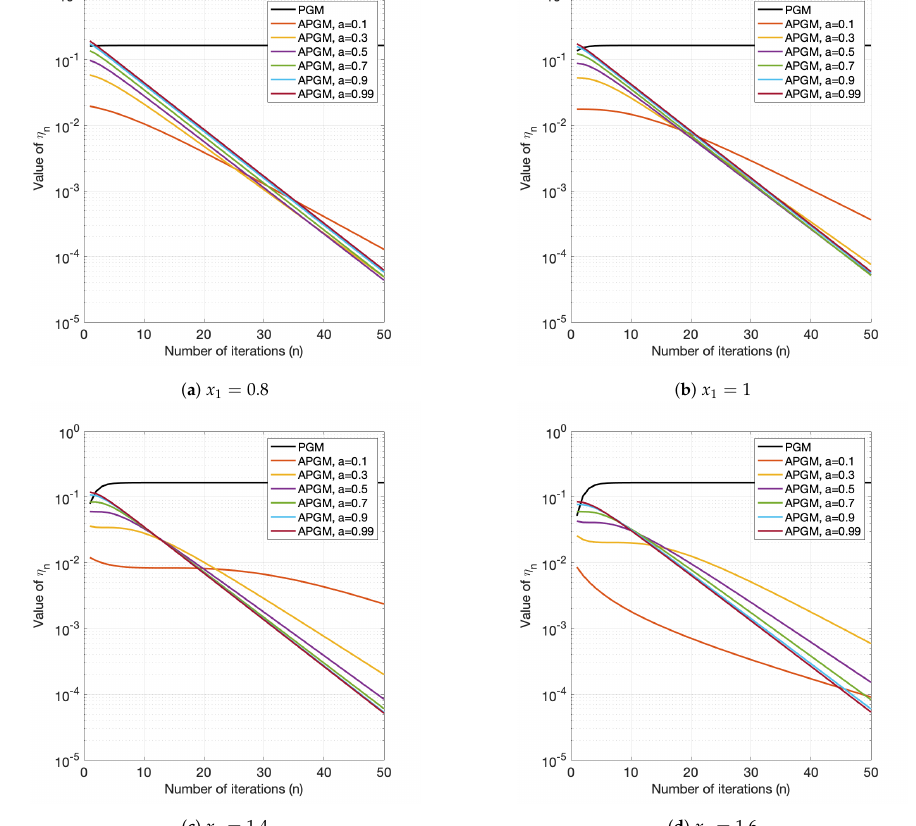
Figure 2. The behavior of the step size η n for different values of the initial point x 1 when performed by PGM and APGM with various values for a